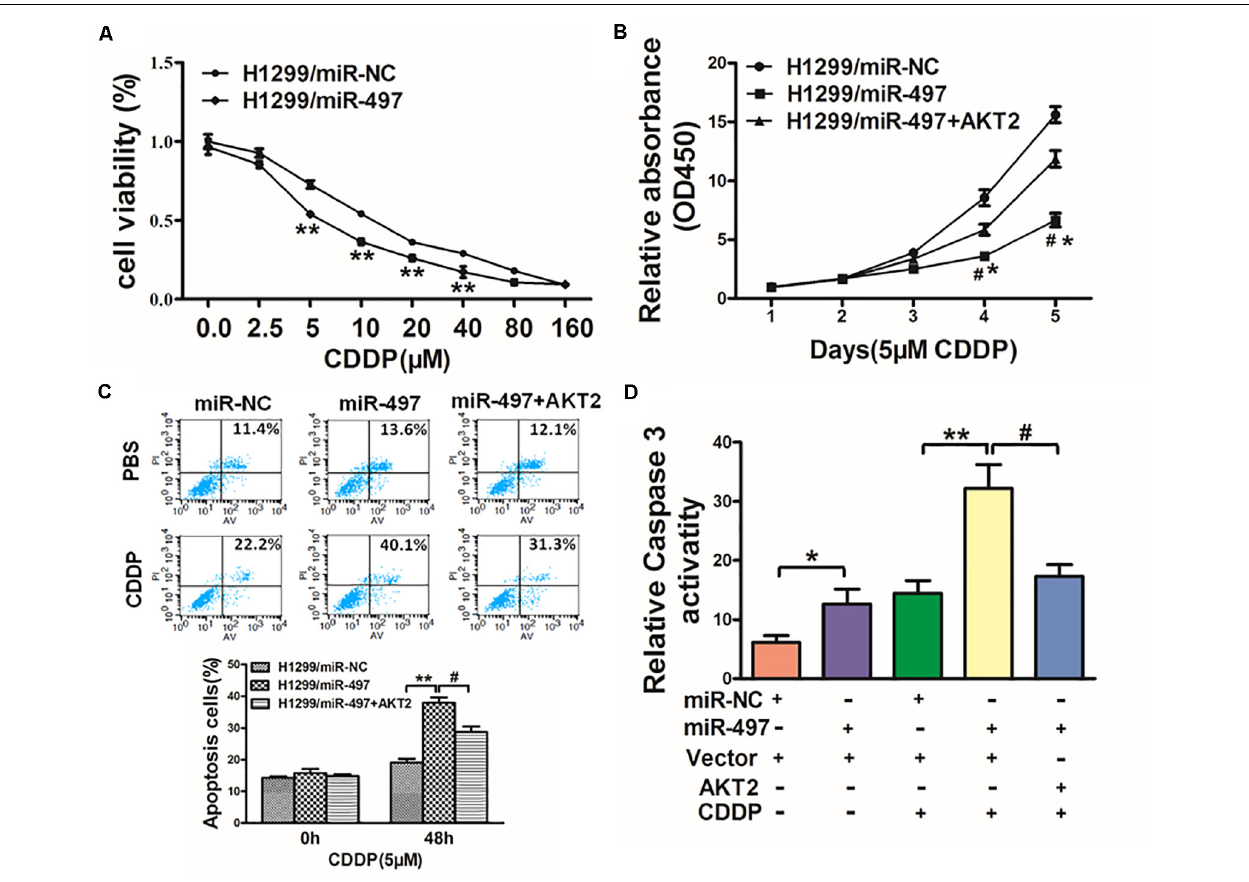
FIGURE 6 | MiR-497 sensitizes lung cancer cells to CDDP treatment by suppressing AKT2. (A) H1299 cells stably expressing miR-NC or miR-497 were treated with different concentrations of CDDP for 48 h, and cell viability was analyzed using CCK-8 assay. (B) H1299 cells stably expressing miR-NC, miR-497, or miR-497 in combination with AKT2 overexpression were treated with 5 µ M of CDDP for indicated time points. Cell viability was analyzed by CCK-8 assay. (C,D) Cell apoptosis was analyzed by flow cytometry and by caspase-3 assay. Data represent mean ± SD from three replicates. *, # indicates P < 0.05; **indicates P < 0.01, *indicates P < 0.05 compared to miR-NC control. # indicates P < 0.05 compared to miR-497 and AKT2 overexpression